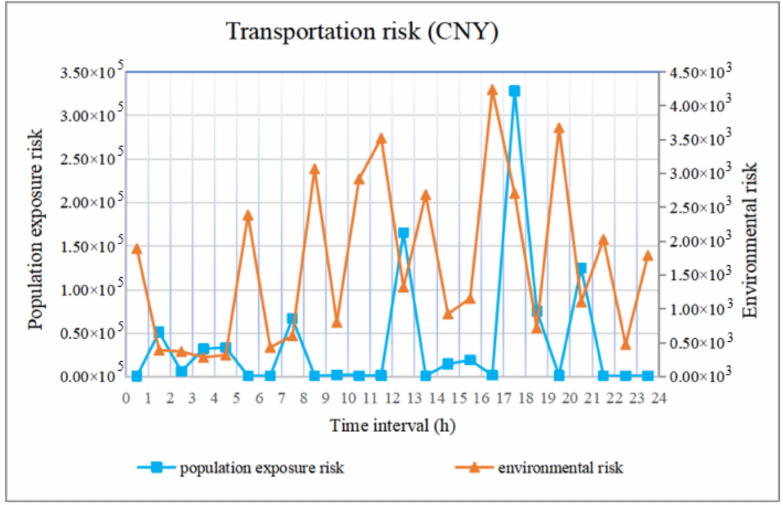
Figure 13. Transportation